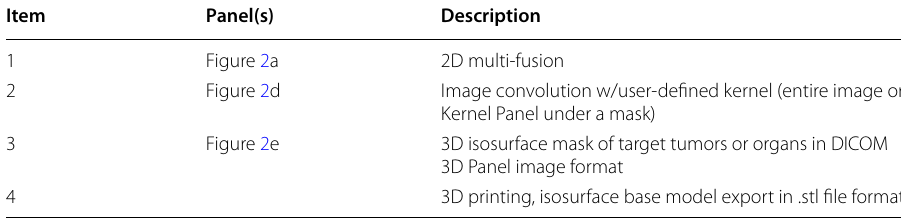
Table 3 TriDFusion image viewer special features Item Panel(s) Description Figure 2a 2D multi-fusion Figure 2d Image convolution w/user-defined kernel (entire image or Kernel Panel under a mask) Figure 2e 3D isosurface mask of target tumors or organs in DICOM 3D Panel image format 3D printing, isosurface base model export in .stl file 2D, two-dimensional; 3D, three-dimensional